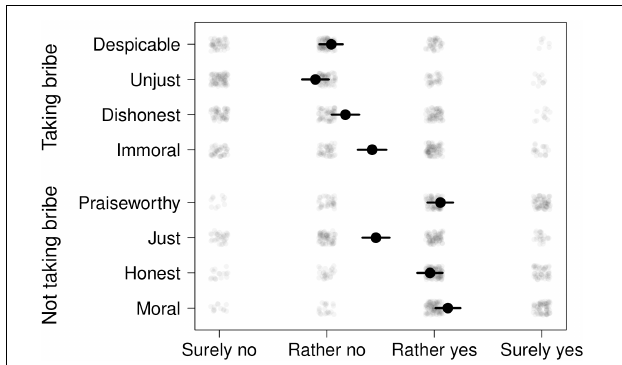
FIGURE 2 | Perception of the task by participants. The answers were coded on a 4-point scale and their means are shown by black points. Error bars represent 95% confidence intervals. The transparent points display individual